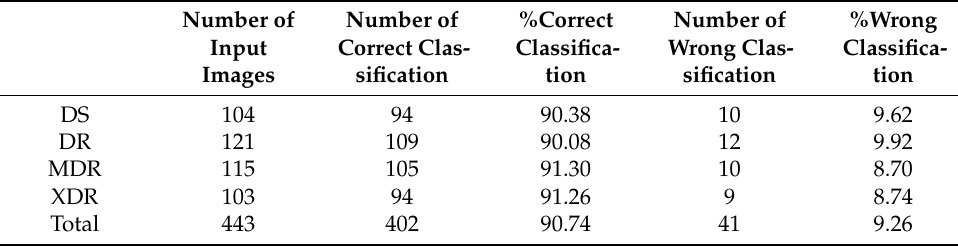
Table 12. The DBOQS accuracy